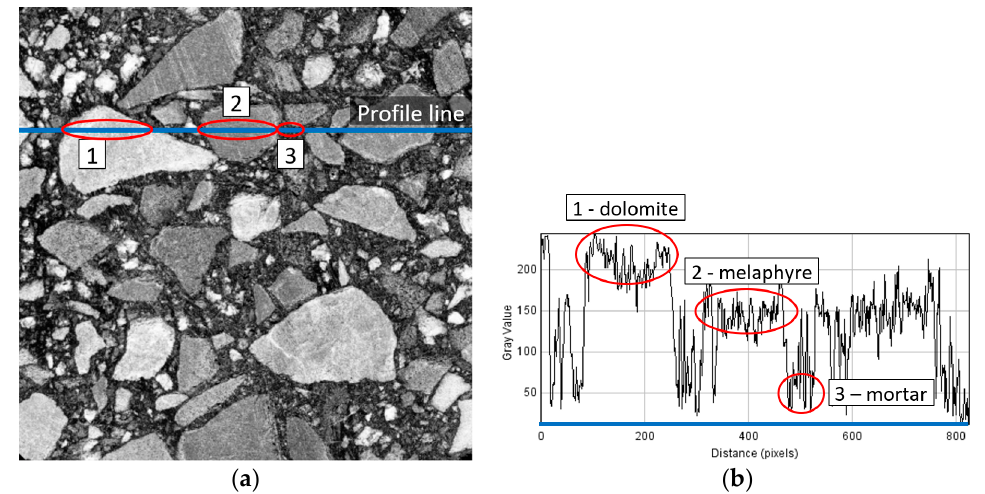
Figure 5. Cross section of asphalt mixture: ( a ) gray image with example of profile line, ( b ) grey plot profile.